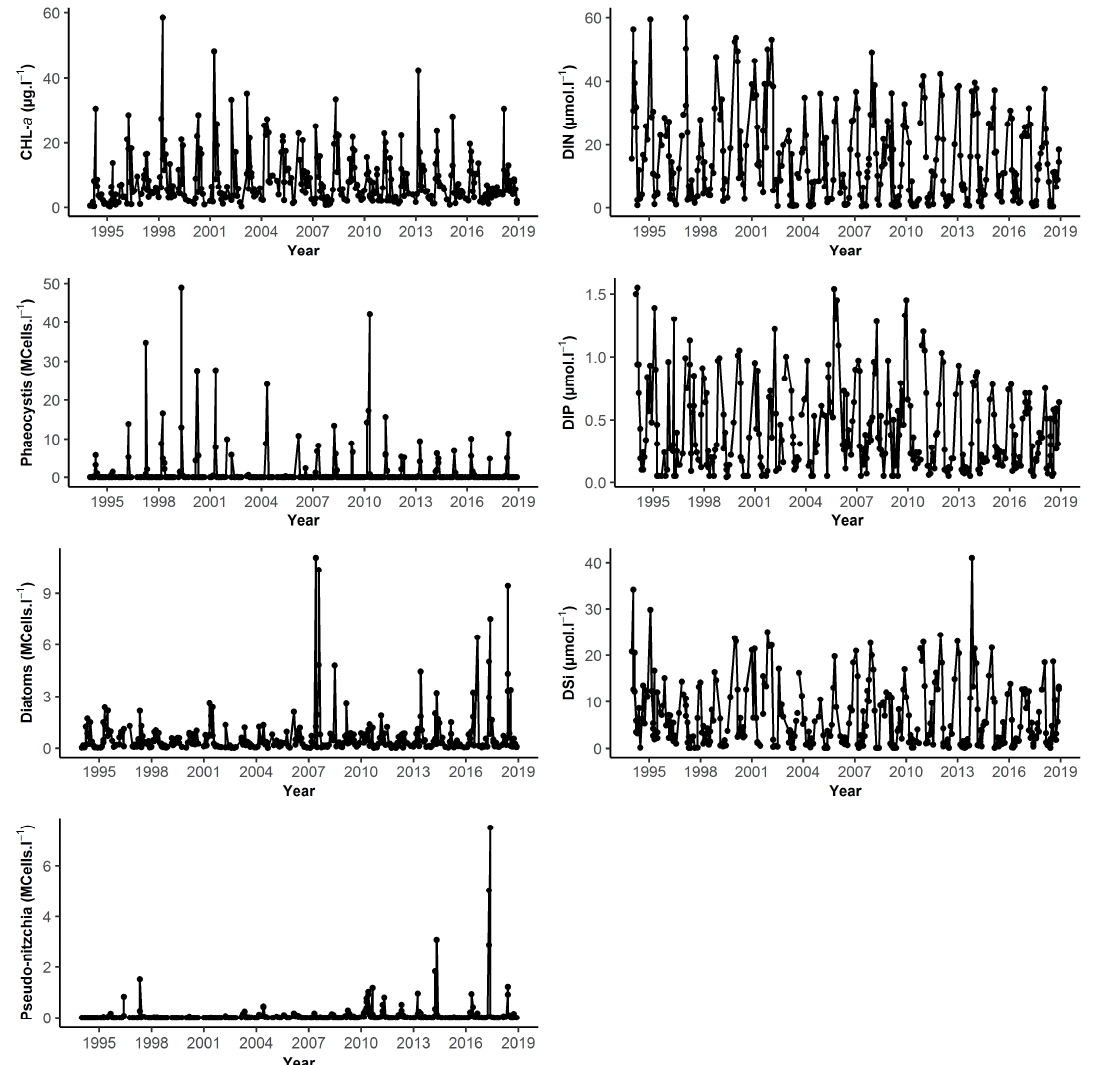
Figure 5. Annual time series of available parameters in the coastal station of the Bay of Somme (S1) for the period 1994–2018 (raw data).